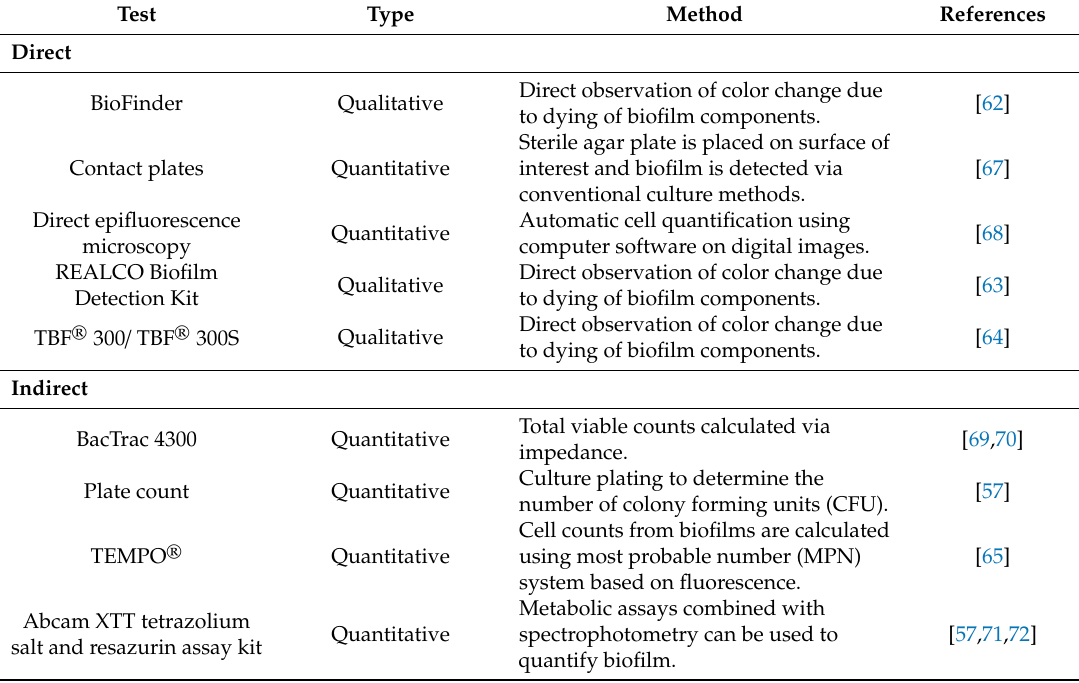
Table 3. Direct and indirect biofilm detection and enumeration methods for food processing